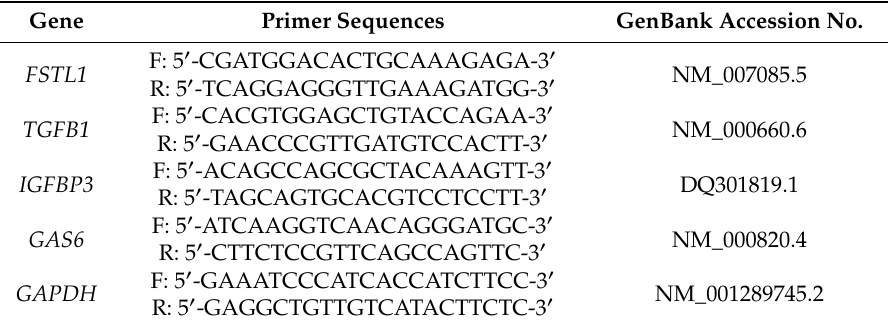
Table 1. DNA sequences of the primers used for